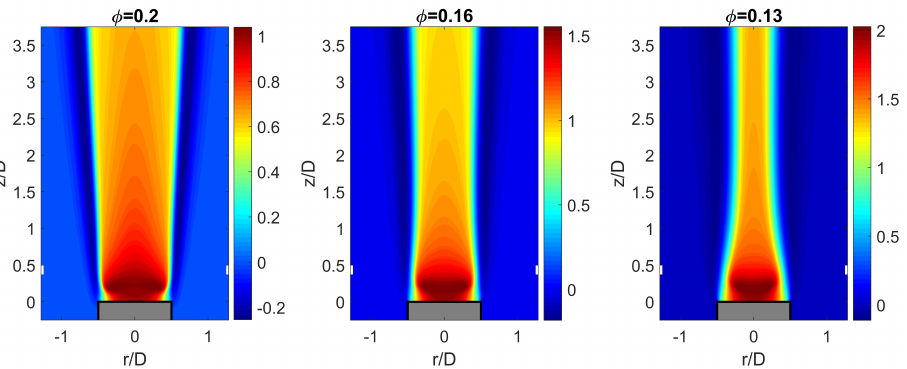
Figure 4. Scaled hydrogen elemental mass fraction Z H − Z H , in away from